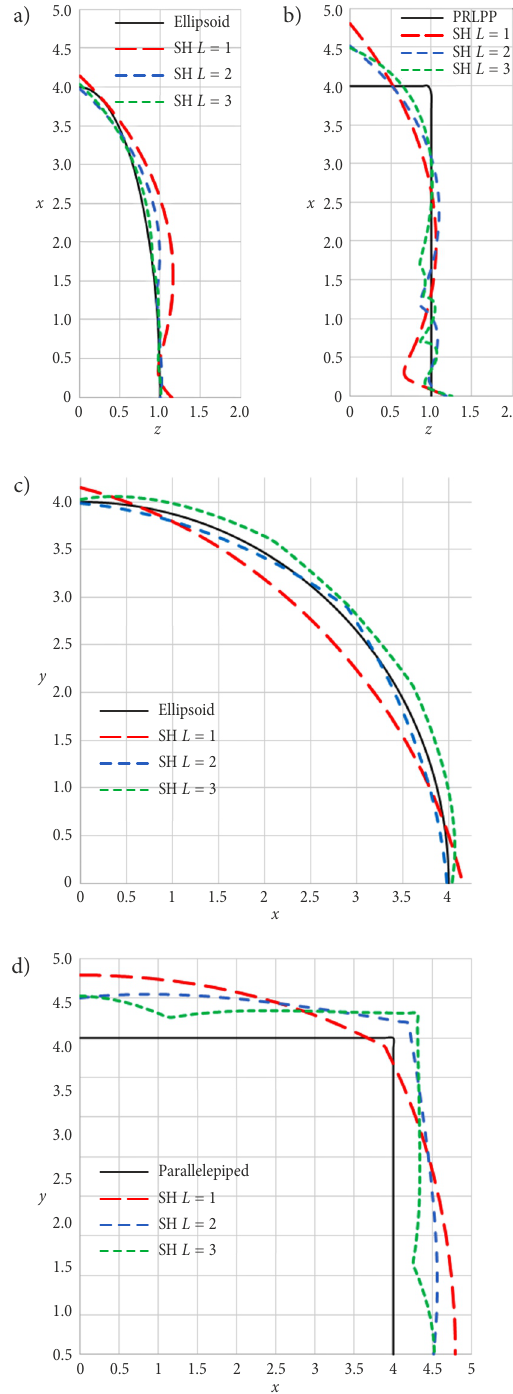
Fig. 4. Cartesian profiles of flattened ( k = 1/4) particles elon obtained by spherical harmonics with different ( L = 1, L = 2, L = 3) expansion degrees: longitudinal profiles (a) and cross- sectional profiles (c) of quasi-ellipsoid; longitudinal profiles (b) and cross-sectional profiles (d) of quasi-prism